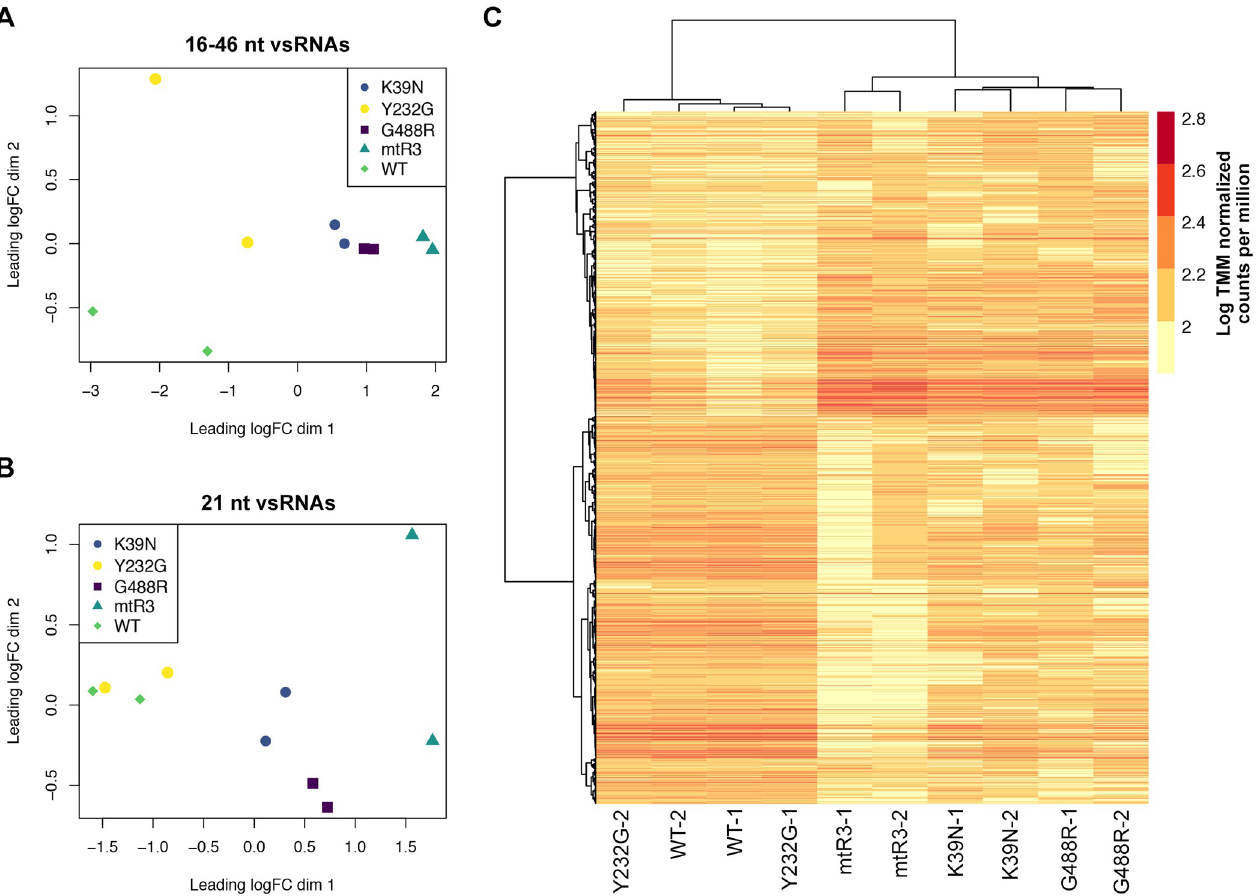
Fig 7. Functional Aaeg Dcr2 generates diverse but highly consistent true 21 nt vsiRNAs. (A) Multi-dimensional scaling (MDS) plot of vsRNAs (16–46 nt) and (B) 21 nt vsRNAs from AF319 cells transiently expressing functional Dcr2 (WT or Y232G; mainly true 21 nt vsiRNAs) or mutant Dcr2 (G488R, K39N, mtR3; mainly vsi-piRNAs) per replicate with axes presented as log fold change (LogFC). (C) Heatmap showing the relationship of 21 nt vsRNAs generated from AF319 cells transiently expressing WT or mutant Dcr2 (as indicated above) during SFV infection. Hierarchical clustering of treatment replicates (columns) and 21 nt vsRNAs (rows) performed by first calculating a distance matrix using Pearson correlation distance and clustered using Ward’s minimum variance method. Each library is shown, and the scale corresponds to log-transformed TMM normalized counts per million.